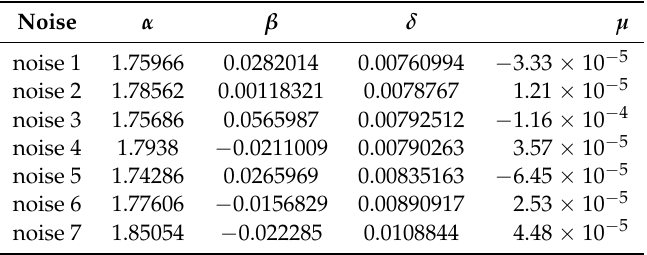
Table 3. The parameters estimation of α stable distribution of noise in